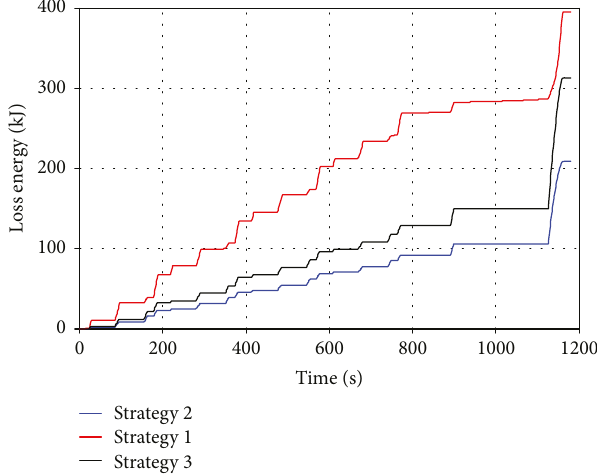
Figure 12: Energy loss of motor system under cyclic condition.